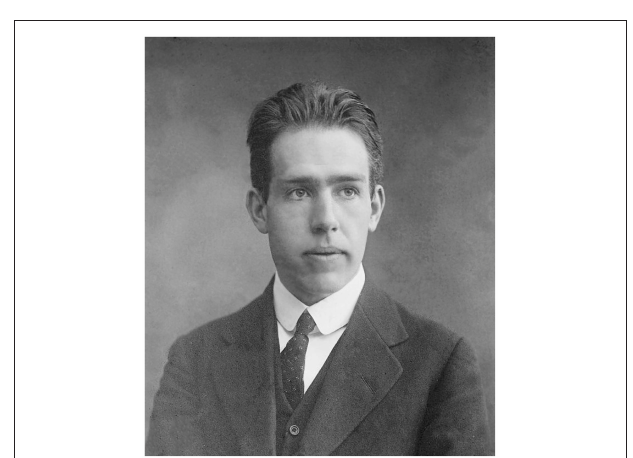
FIGURE 1 | Hermann von Helmholtz.